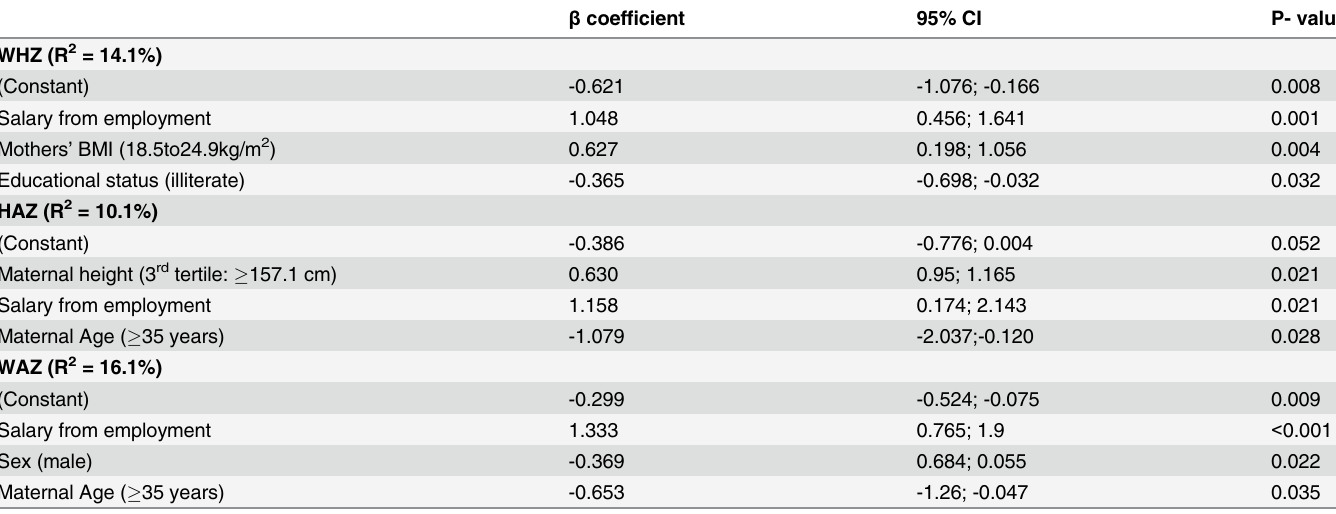
Table 4. Predictors of children ’ s WHZ, HAZ and